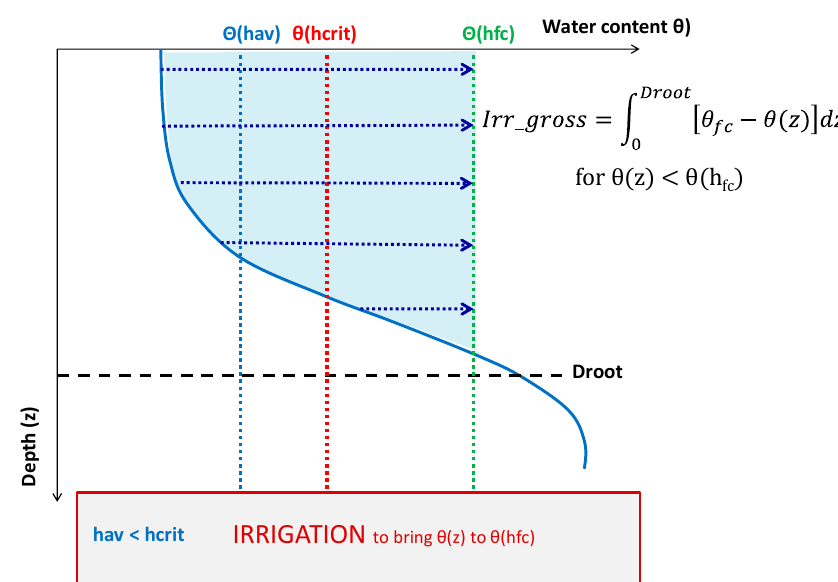
Figure 2. Graphical view of the irrigation volume calculation according to the criterion shown in Figure 1.